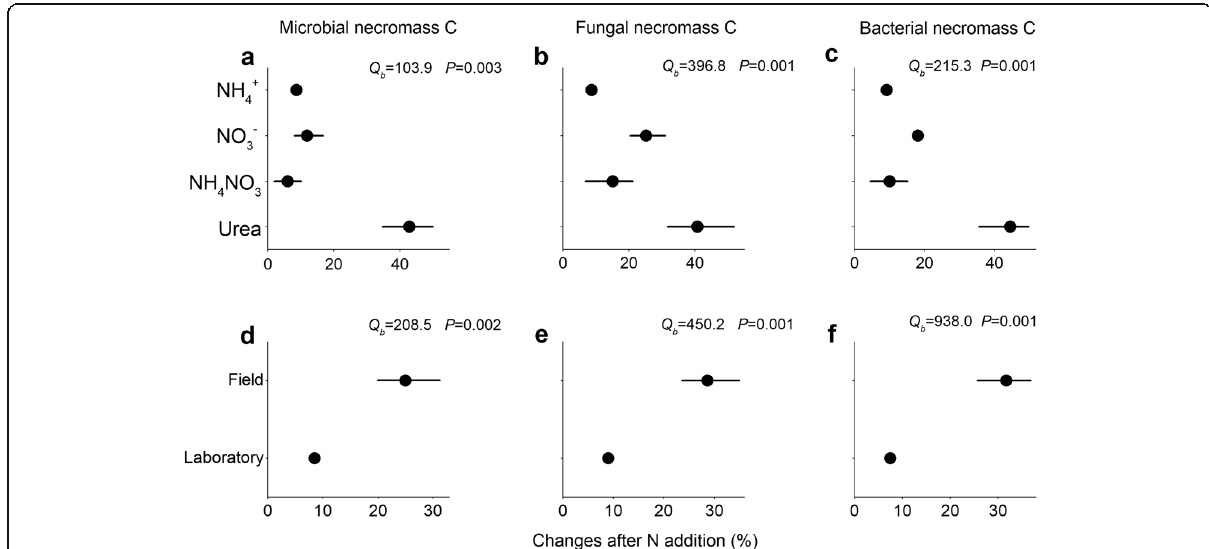
Fig. 6 Percent changes in microbial necromass C under different N forms (upper) and experimental conditions (lower). a , d Total microbial necromass C, b , e fungal necromass C, and c , f bacterial necromass C. Error bars represent the 95% bootstrap confidence intervals that were calculated by weighted effect sizes. The responses of these variables to different N forms and experimental conditions are considered significant ( P < 0.05) if the 95% bootstrap confidence intervals do not overlap with zero. The between-group heterogeneities ( Q b ) and the probabilities ( P ) of the effects of N addition on microbial necromass C across different N forms and experimental conditions are shown in each